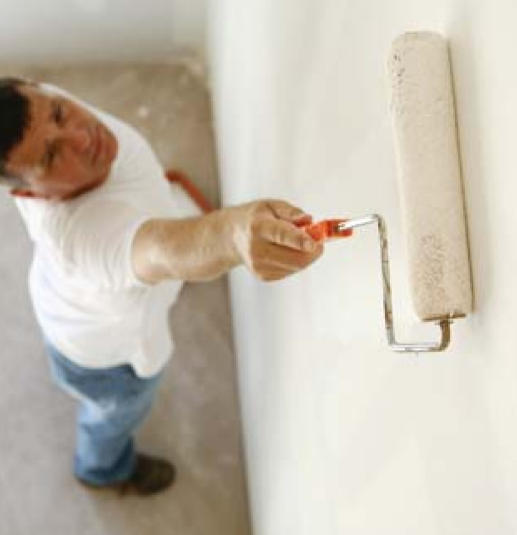
PaintLow- and no-VOC paints and finishes offgas significantly less than conventional products.